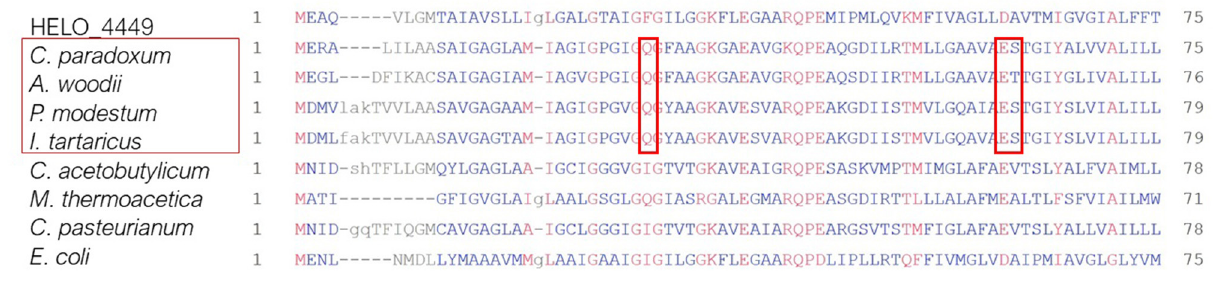
FIGURE 8 | Alignment of various F-type ATP synthase c subunits for determination of the ion specificity for H. elongata . Commonly a glutamine (Q), glutamate (E) and serine (S) residue is needed for the binding of sodium which neither is present in the H. elongata F-type ATPase. The highest similarity was found with E. coli which is a proton translocating F-type ATP